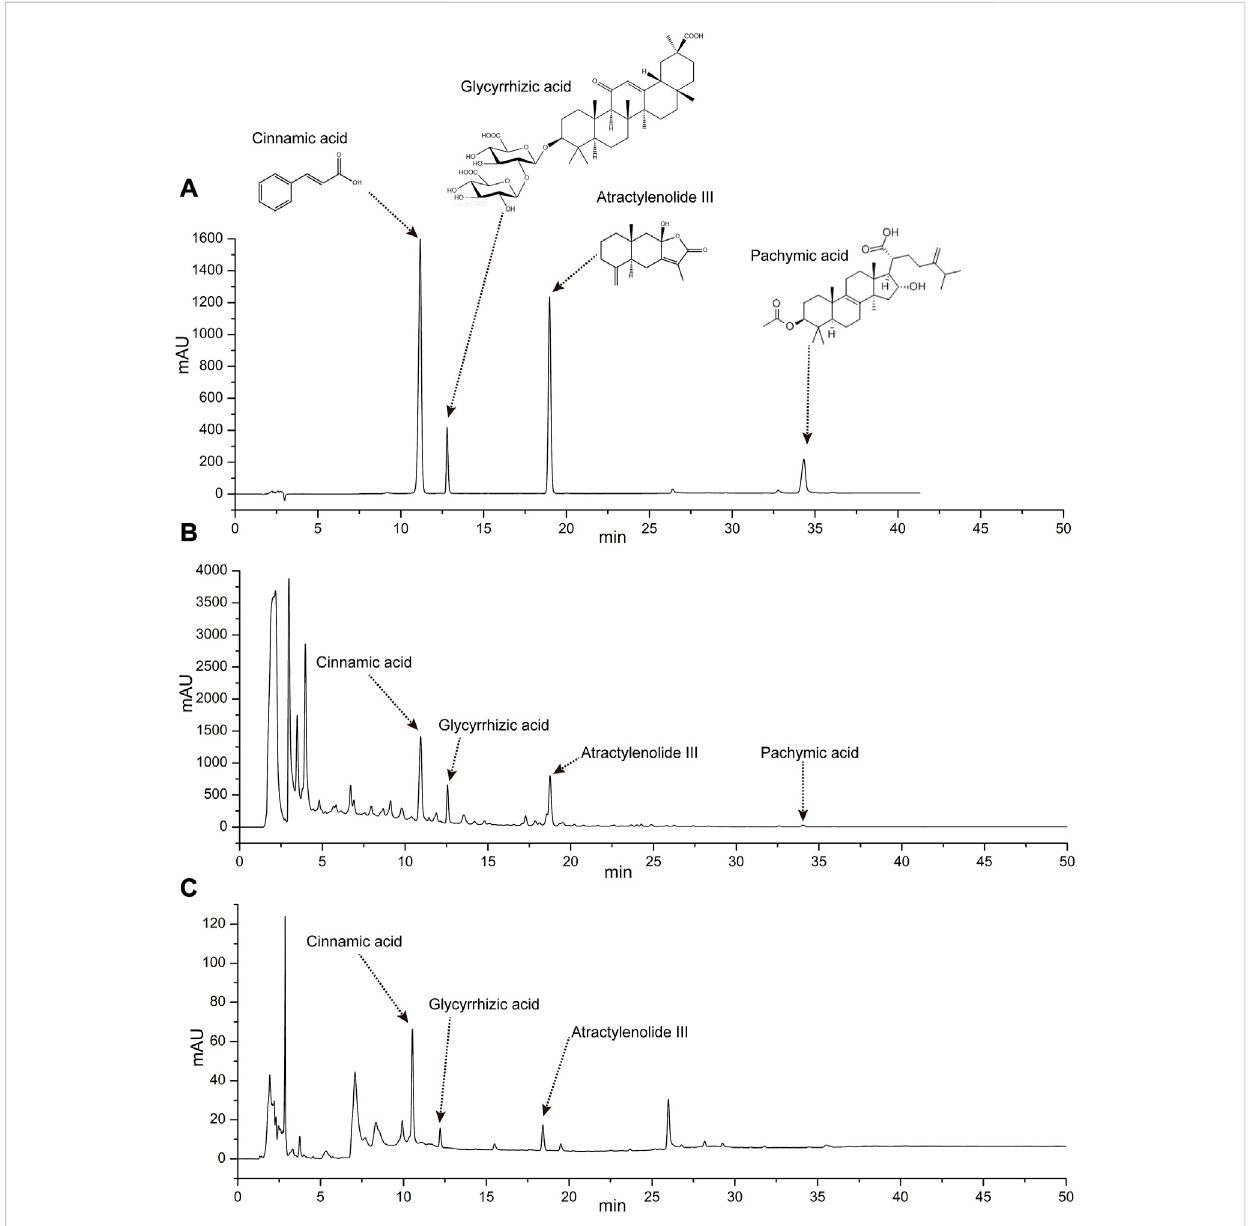
Determination of four chemical constituents of cinnamic acid, glycyrrhizic acid, atractylenolide III, and pachymic acid by HPLC. (A) High performance liquid chromatogram of the four chemical composition standards. (B) High performance liquid chromatogram of Linggui Zhugan Decoction. (C) High performance liquid chromatogram of rat serum after 1 h gavage of Linggui Zhugan